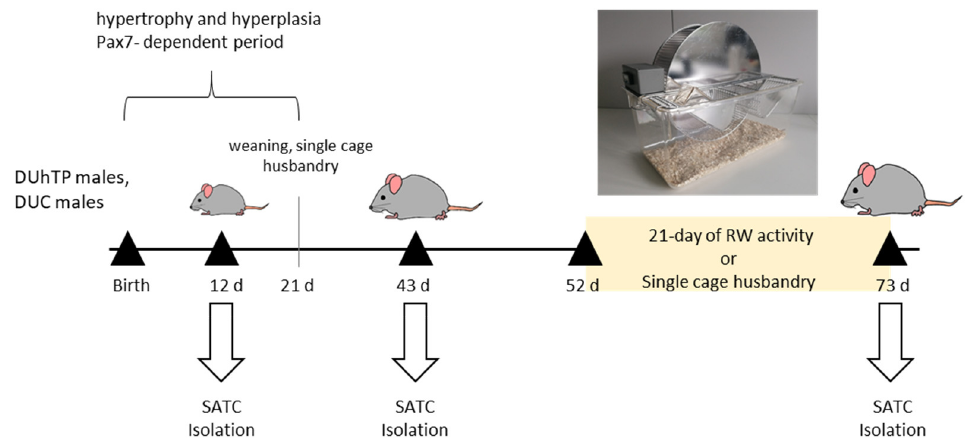
Figure 1. Experimental design. For the isolation of primary myogenic precursor cells/satellite cells from whole limb muscles, male DUC and DUhTP mice of different ages (12, 43, and 73 days) were used. Seventy-three-day-old mice either had access to a running wheel (RW) with a wheel counter (Tecniplast, Hohenpeißenberg, Germany) from day 52 of age or were kept entirely under sedentary conditions.